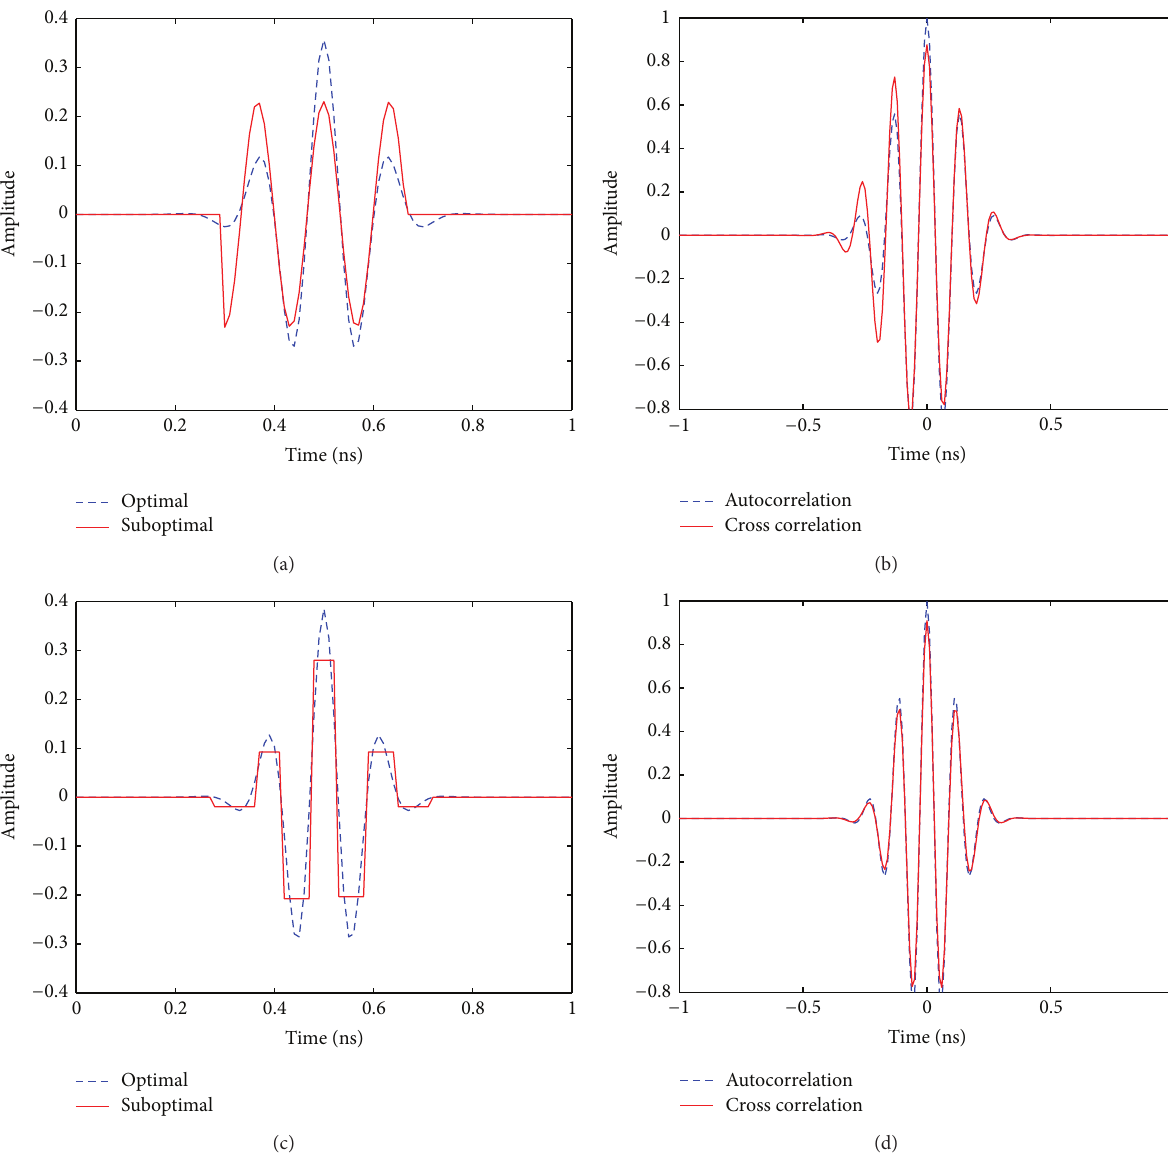
Figure 2: (a) Eighth-order Gaussian pulse and the corresponding suboptimal sinusoidal template. (b) Eighth-order Gaussian pulse autocorrelation and cross correlation with the corresponding suboptimal sinusoidal template. (c) Eighth-order Gaussian pulse and the corresponding suboptimal square pulse template. (d) Eighth-order Gaussian pulse autocorrelation and cross correlation with the corresponding suboptimal square pulse